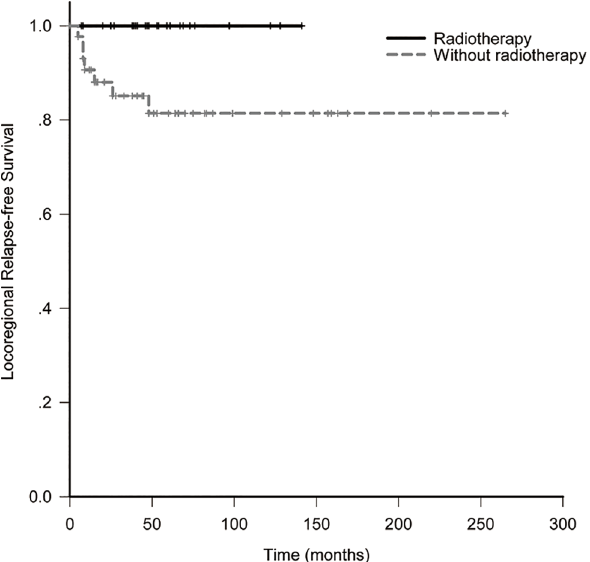
Fig 1. Locoregional relapse-free survival of patients with or without